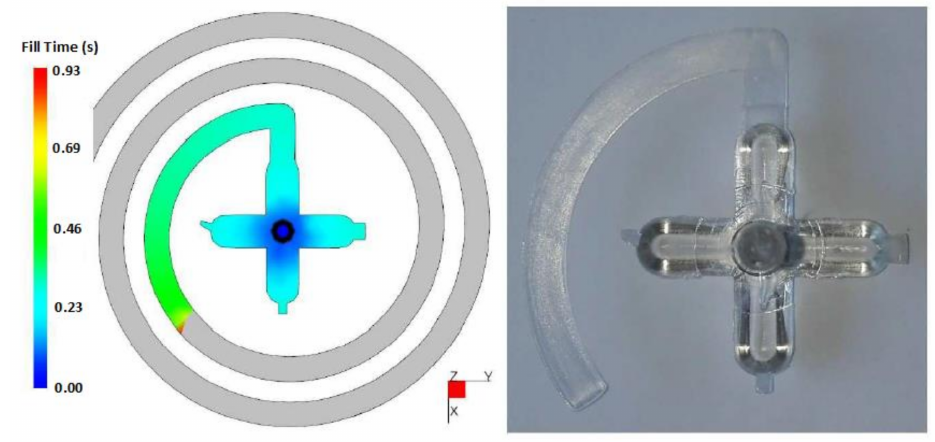
Figure 3. Comparison of the flow length displayed in simulation and the physical test sample (material PC, injection pressure 600